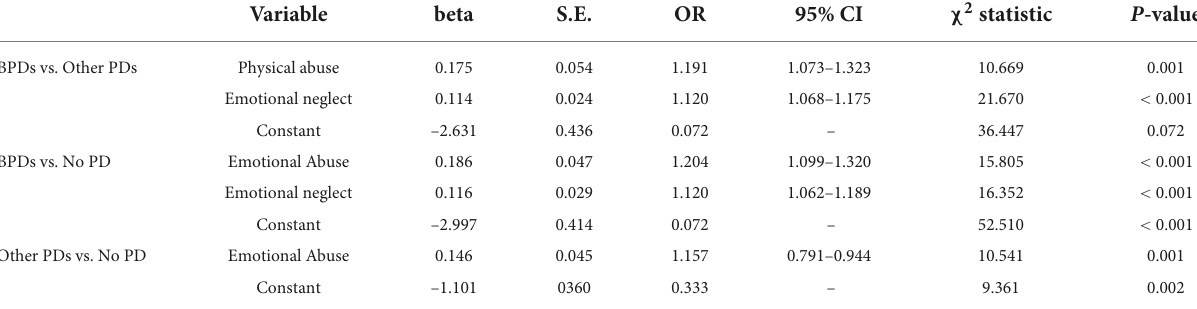
TABLE 2 Forward stepwise logistic regression for risk factors predicting the clinical diagnoses of different PD groups. Variable